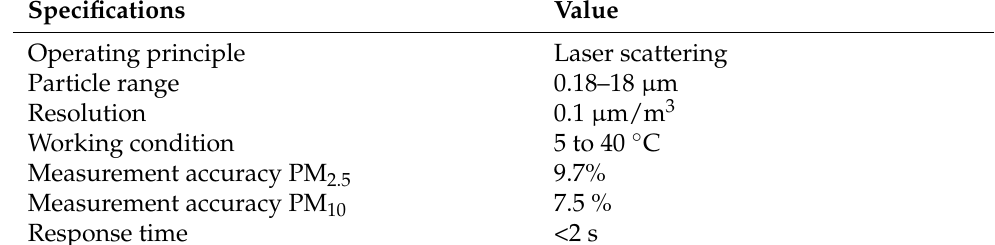
Table 3. Technical specifications of the reference PM measurement station, Fidas200 [3,27].